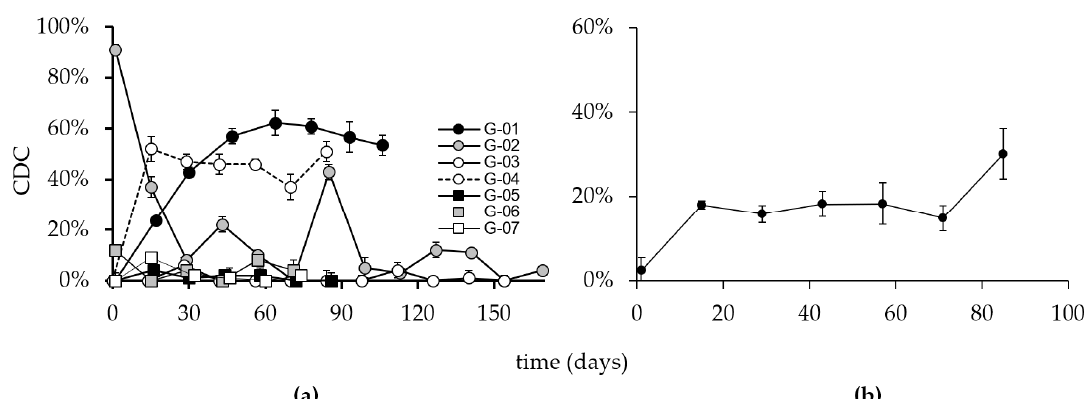
Figure 5. CDC activity in the sera of immunized patients. Blood samples are collected on the indicated days, as shown in the above figure. Sera of the seven patients were then analyzed using calcein-AM-based cytotoxicity assay as described in the methods. ( a ) Percent activity is depicted in the above figure for each patient. ( b ) Mean CDC activity of all patients. Y -axis: CDC% of target cell lysis, X -axis: vaccination time points. Error bars indicate the standard deviation.